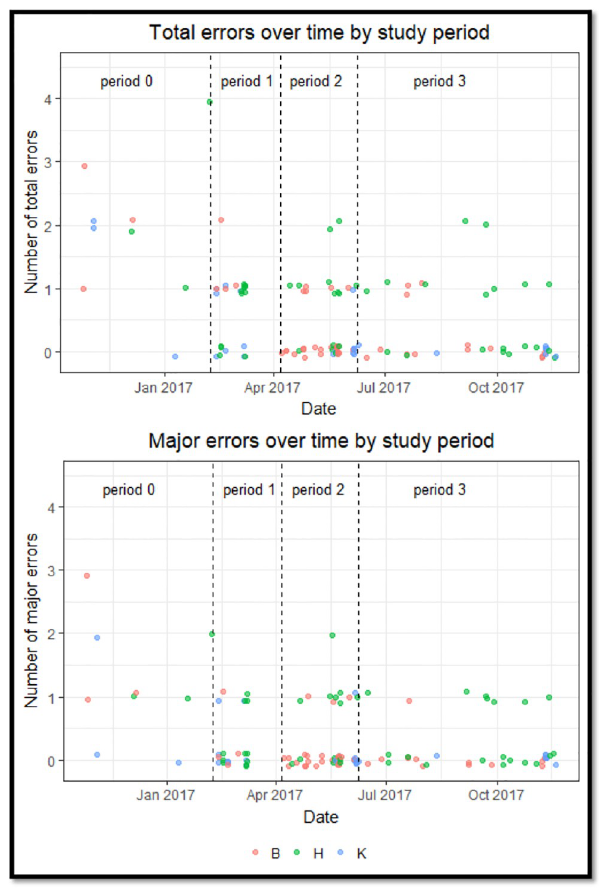
Fig 3. Number of errors in each simulation by calendar date. Point colors correspond to the three standardized family members who are represented by their first initials B, H, and K.